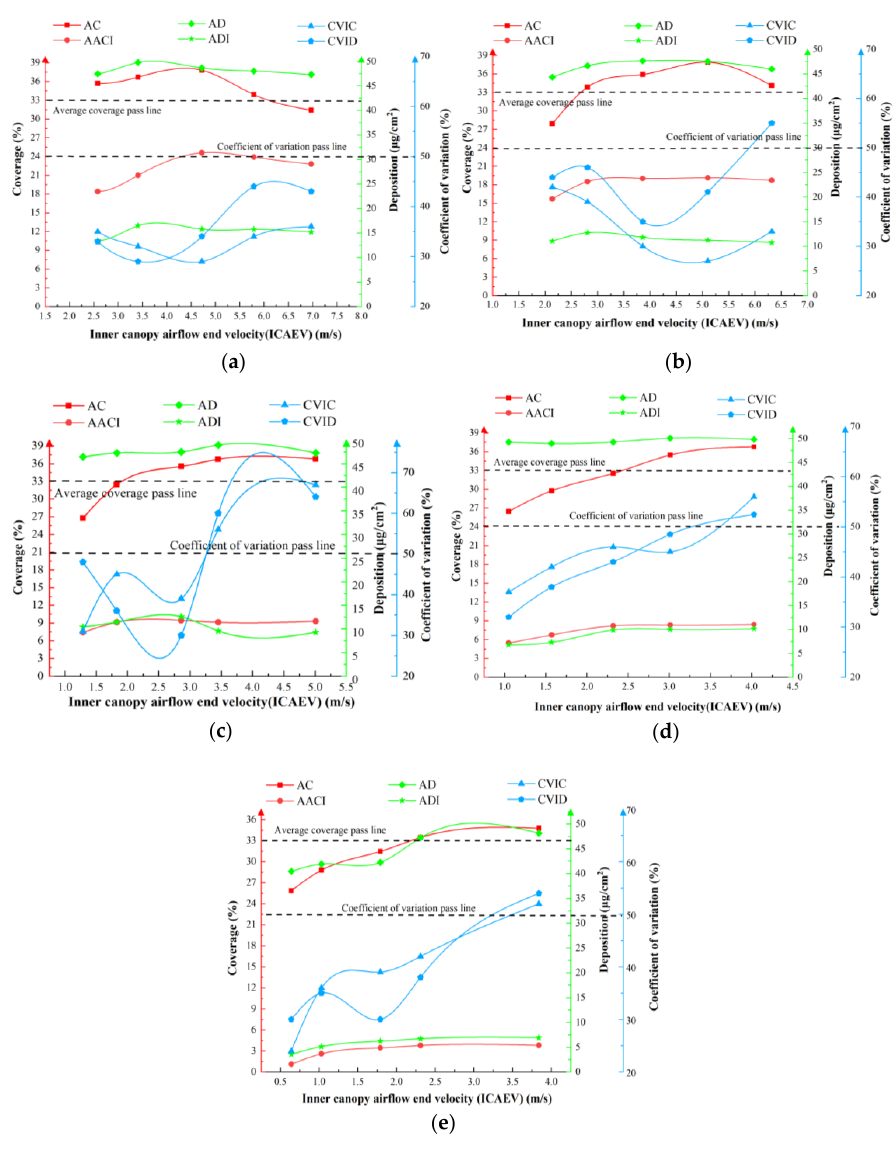
Figure 6. Variation curves of six indicators of pear trees with five canopy sizes under different inner canopy airflow end velocity. ( a ) Crown diameter 0.8 m. ( b ) Crown diameter 1.0 m. ( c ) Crown diameter 1.2 m. ( d ) Crown diameter 1.4 m. ( e ) Crown diameter 1.6 m.